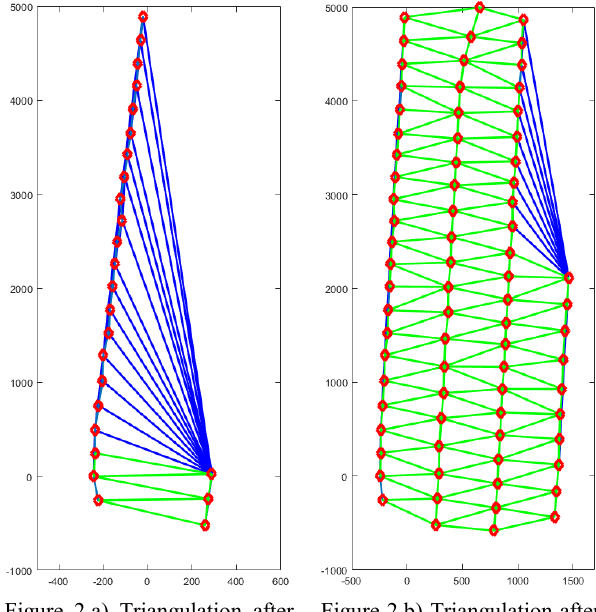
Figure 2.b) Triangulation after 76 images (valid edges in green, rejected edges in blue)